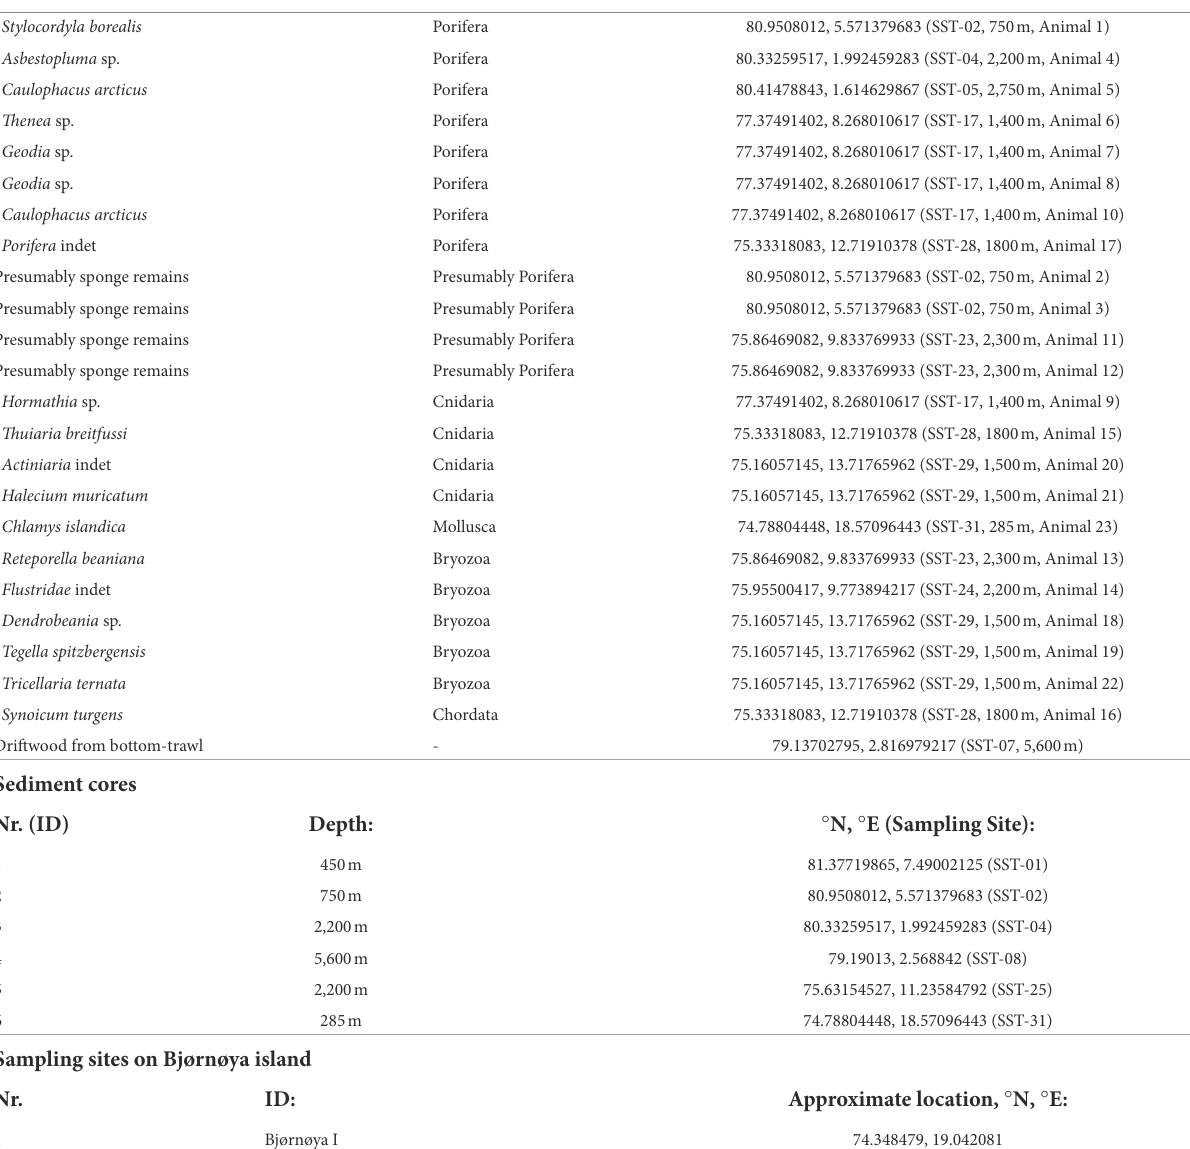
TABLE 1 The list of the samples (including sediment, animals, drift-wood) and sampling sites (intertidal sediment and soil at Bjørnøya) from which actinobacteria have been isolated. Animal-, and other samples collected Sample Phylum (if